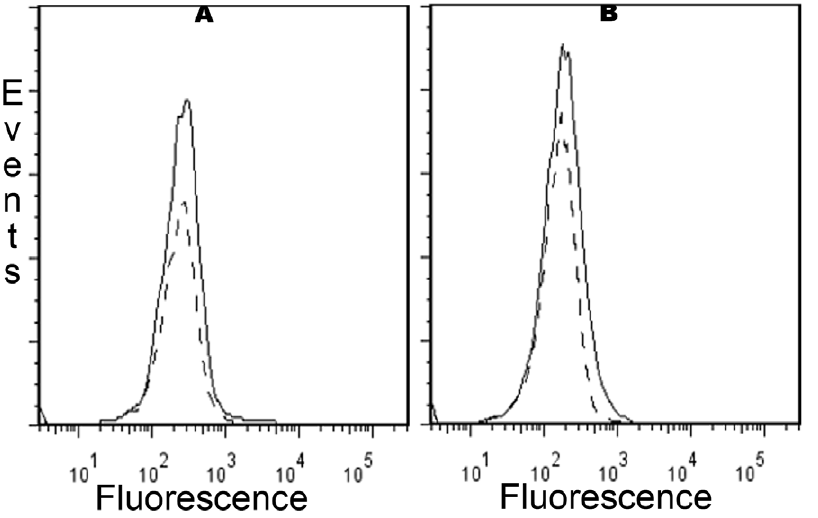
Figure 1. Low expression of the pan neurotrophin receptor p75 NTR on fresh and activated mouse NK cells. Splenocytes were stained with anti-NK1.1, anti-CD3 and anti-p75 NTR Ab or isotype control as described in Materials and Methods, and analyzed by flow cytometry. Dead cells were excluded by staining with Live Dead cell marker. A gate was set on NK cells (CD3-NK1.1 + ). Only a weak expression of p75 NTR (grey lines) relative to isotype control (dashed lines) was observed at day 0 (left panel) and after 5 days of culture in the presence of IL-2 (right panel). Data shown are from one representative experiment out of three performed.